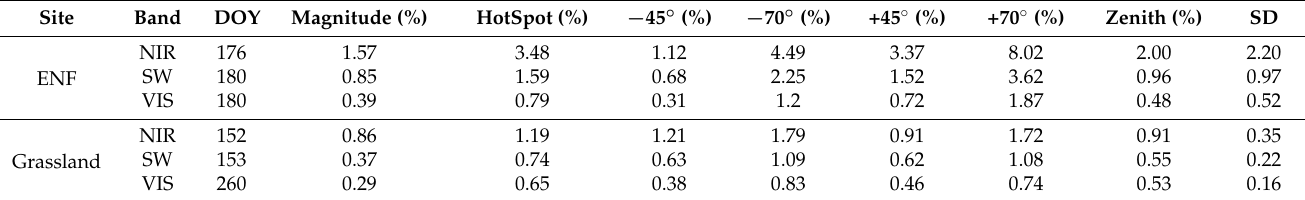
Table 4. Differences in BRDF principal planes due to spatial smoothing for ENF and Grassland in extreme